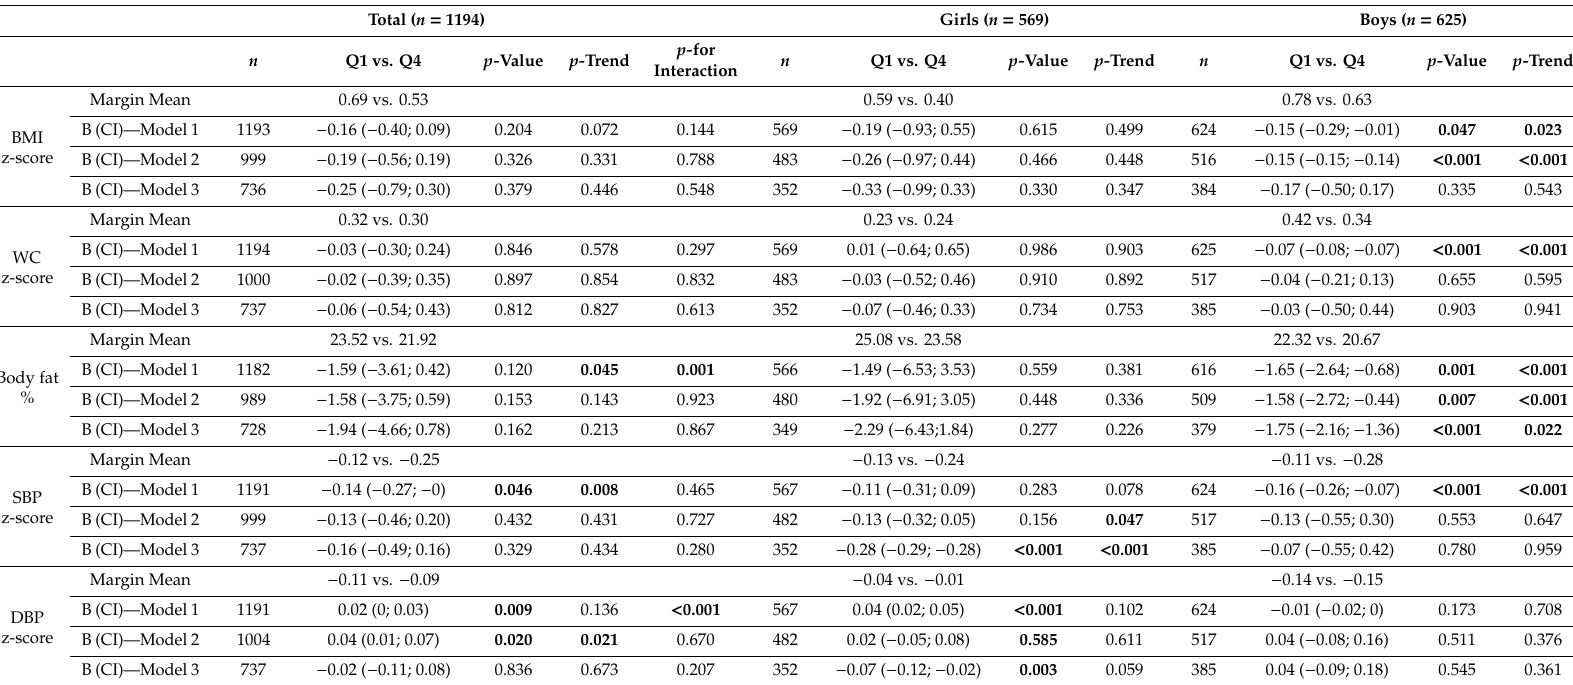
Table 4. Association between body composition and BP with quartiles of TPE (mg GAE / g creatinine), according to